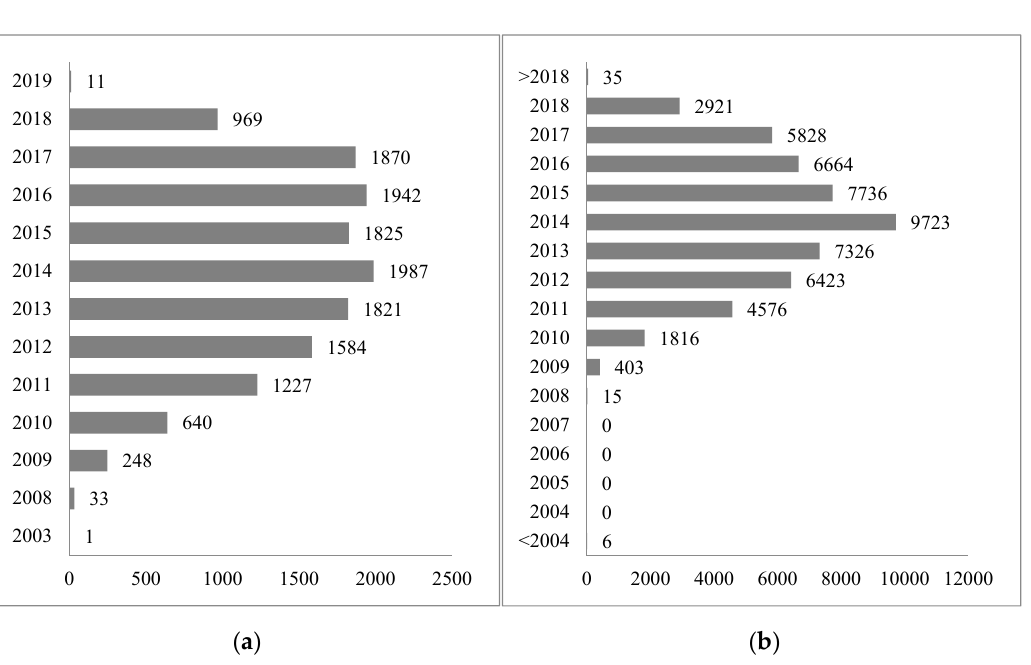
Figure 1. Scientific productivity of research on cloud computing: ( a ) number of publications; and ( b ) number of citations. Source: Own study based on data retrieved from Scopus database (accessed 20 July 2018).